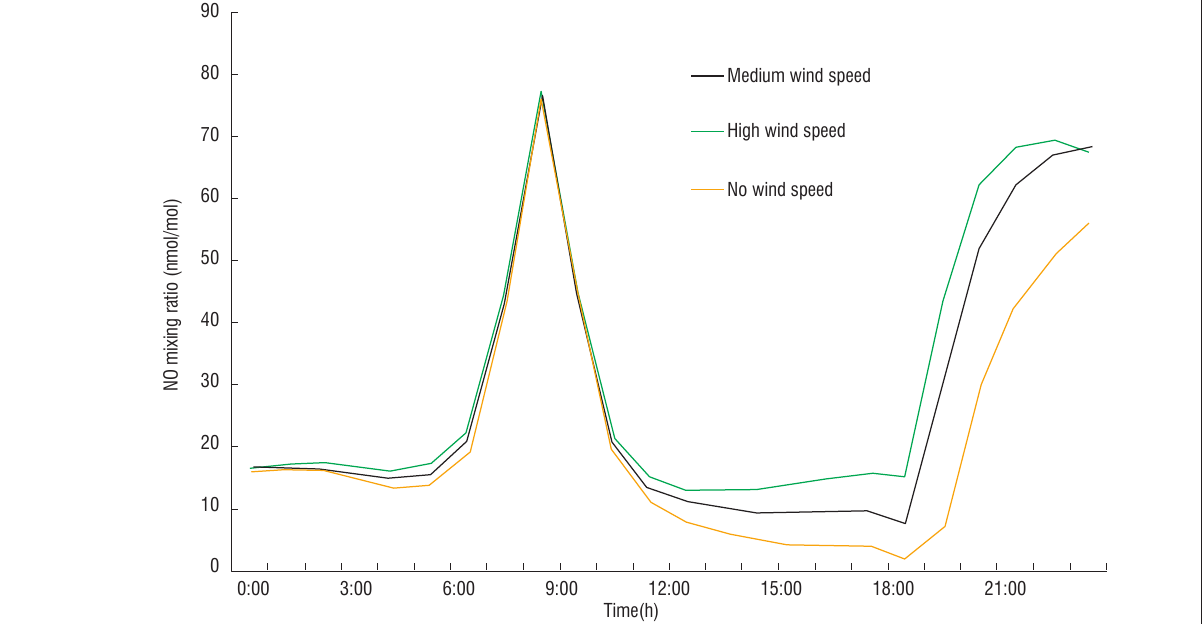
mixing ratios with changes in wind speed. 3